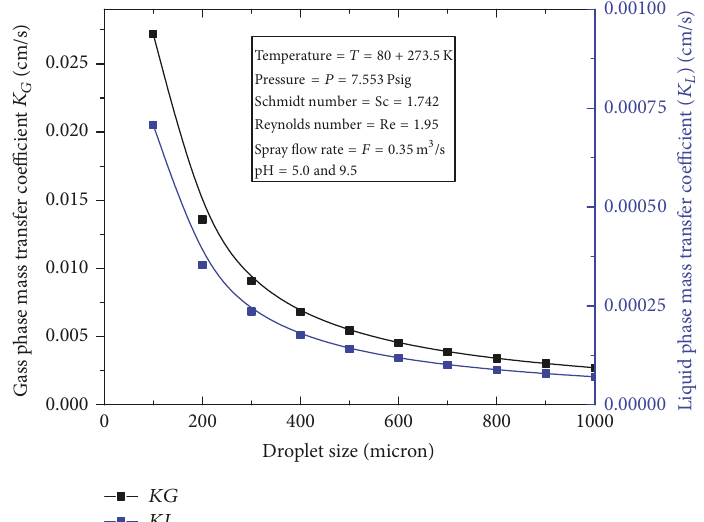
Figure 16: A comparison of gas phase mass transfer coefficient ( 𝐾 퐺 ) and liquid phase mass transfer coefficients ( 𝐾 퐿 ) for elemental iodine constant pH = 5.0 and 𝑇 = 80 ∘